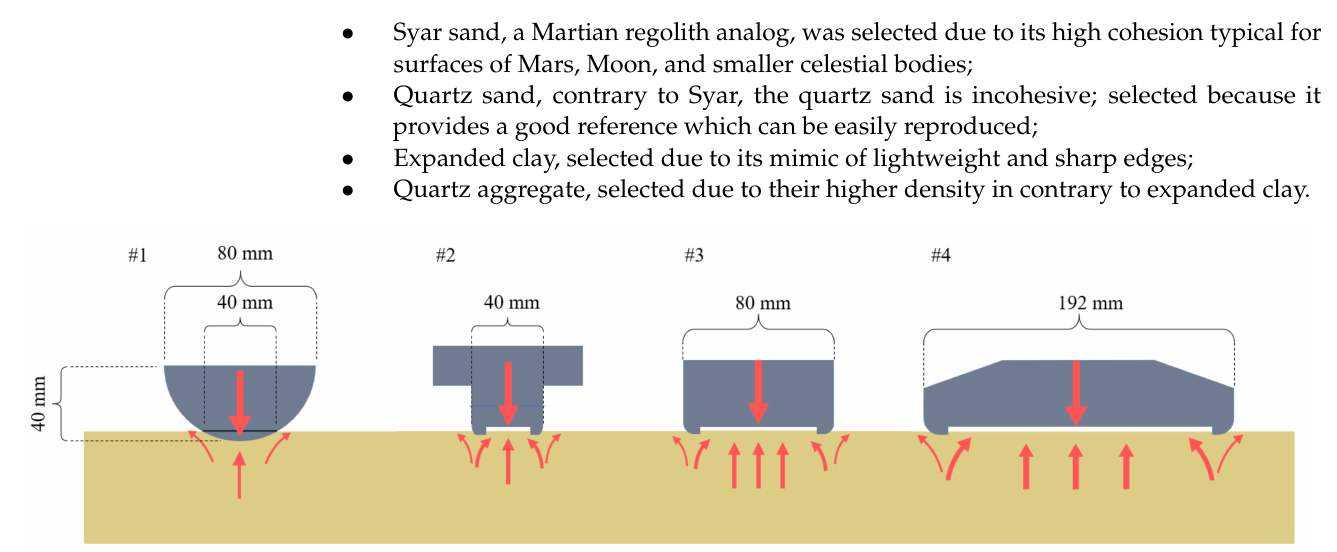
Figure 13. Dimensions and details of the configurations #1, #2, #3 and #4. The extrusion of the shapes is 134 mm.